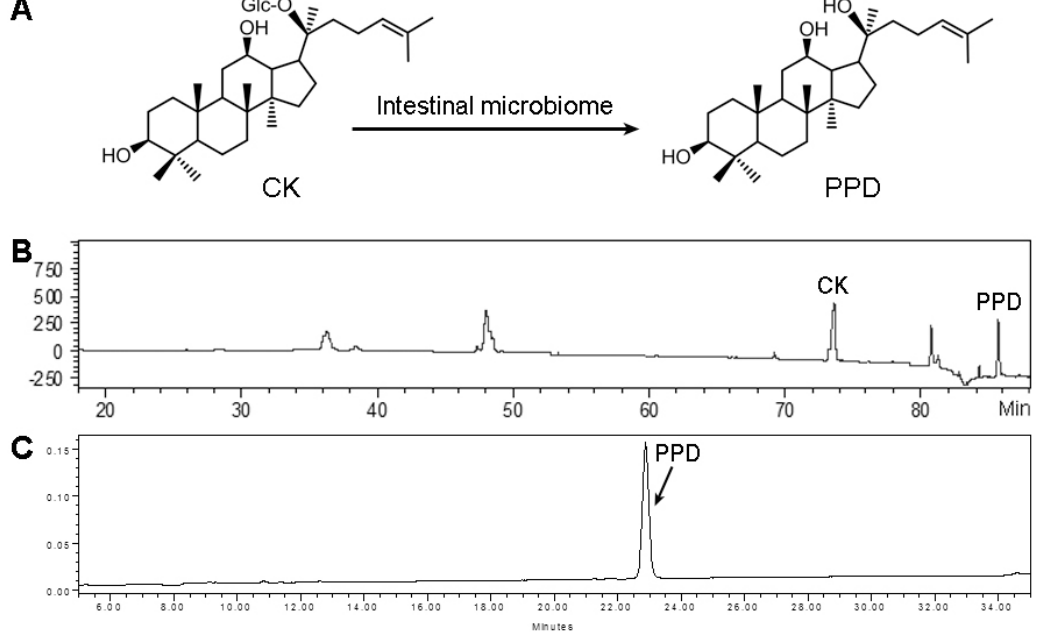
Figure 1. In vitro evaluation to assess the effects of the human stool microbiome in metabolizing compound K (CK) and the protopanaxadiol (PPD) purity test. ( A ) Chemical structures of CK and PPD; ( B ) typical HPLC-MS chromatogram of CK biotransformation by the intestinal microbiome; ( C ) the purity of synthesized PPD was determined using HPLC-UV